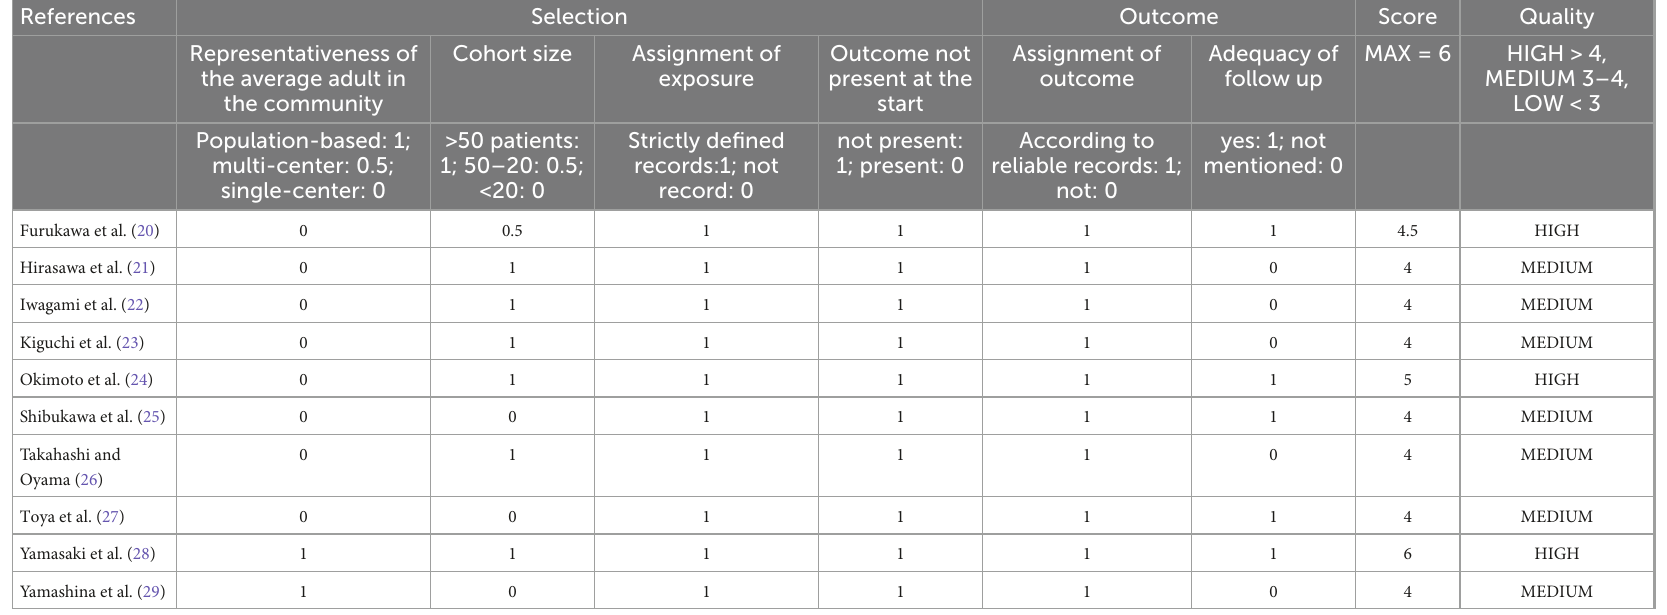
TABLE 2 Study quality